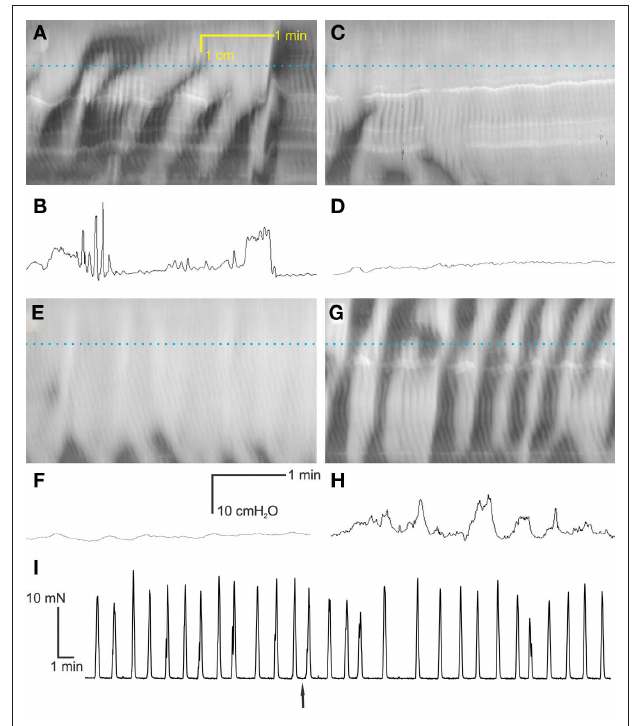
FIgurE 3 | Are rhythmic propulsive motor complexes neurogenic? Spatiotemporal maps (A,C,E,g) and corresponding intraluminal pressure recordings [ (B,D,F,H) respectively] of the same preparations under control conditions (A,B) , 100 μM lidocaine (C,D) , 100 μM lidocaine + 1 μM carbachol (E,F) and 100 μM lidocaine + 4 μM carbachol (g,H) . (I) Stretch evoked contractions of rat colon circular muscle strips in vitro (muscle bath), occurring at the same frequency as the rhythmic propulsive motor complexes, were not influenced by the addition of 100 μM lidocaine (added at arrow).